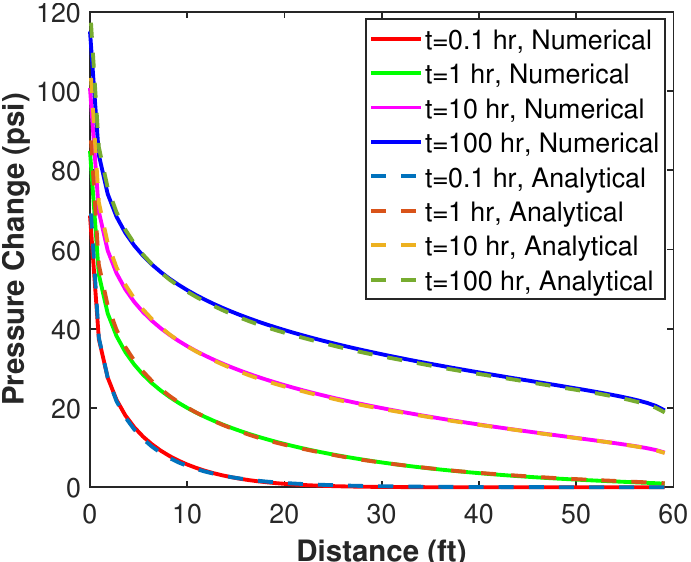
Figure 6. Pressure change profile versus radial distance between the injector and the leakage wells in the lower